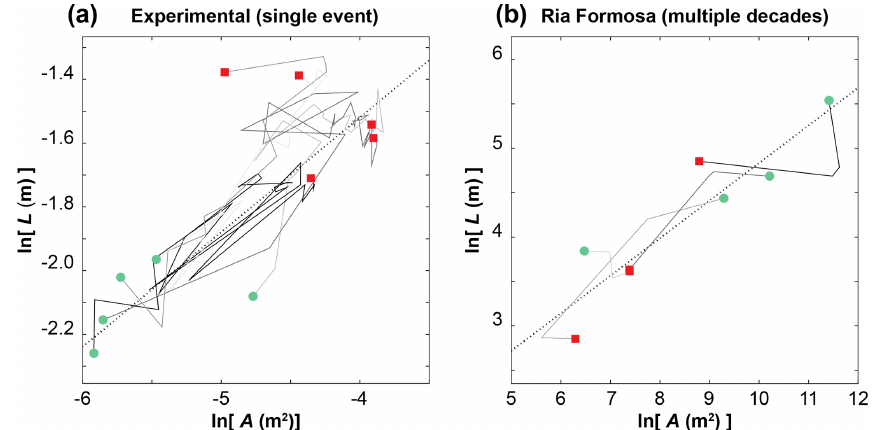
Figure 5. Dynamic allometry in a sample of individual washovers (a) tracked during the physical experimental trials, representing a single forcing event ( n = 5) and (b) identified in the four decades of aerial photographs from Ria Formosa ( n = 4). Circles and squares indicate first and last measurements in the sequence, respectively. Individual trajectories are differentiated by shade (greyscale). Fits are ensemble means from Fig. 3 and listed in Table